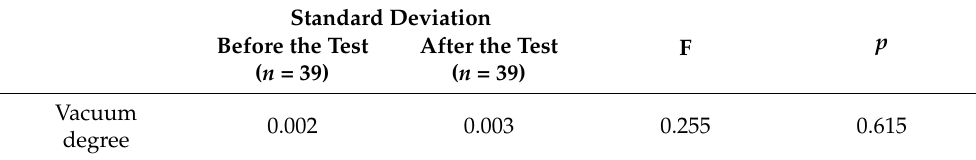
Table 4. Homogeneity of variance test of vacuum degree before and after 12,000 fatigue tests. Standard Deviation